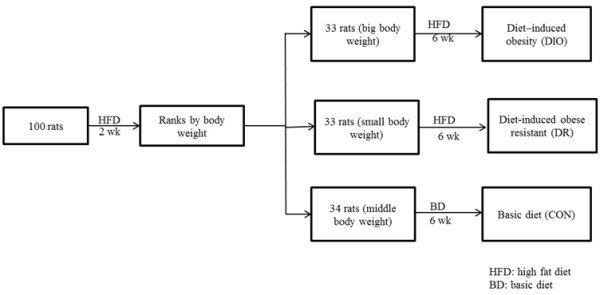
The study design and the flow of treatment groups and times.